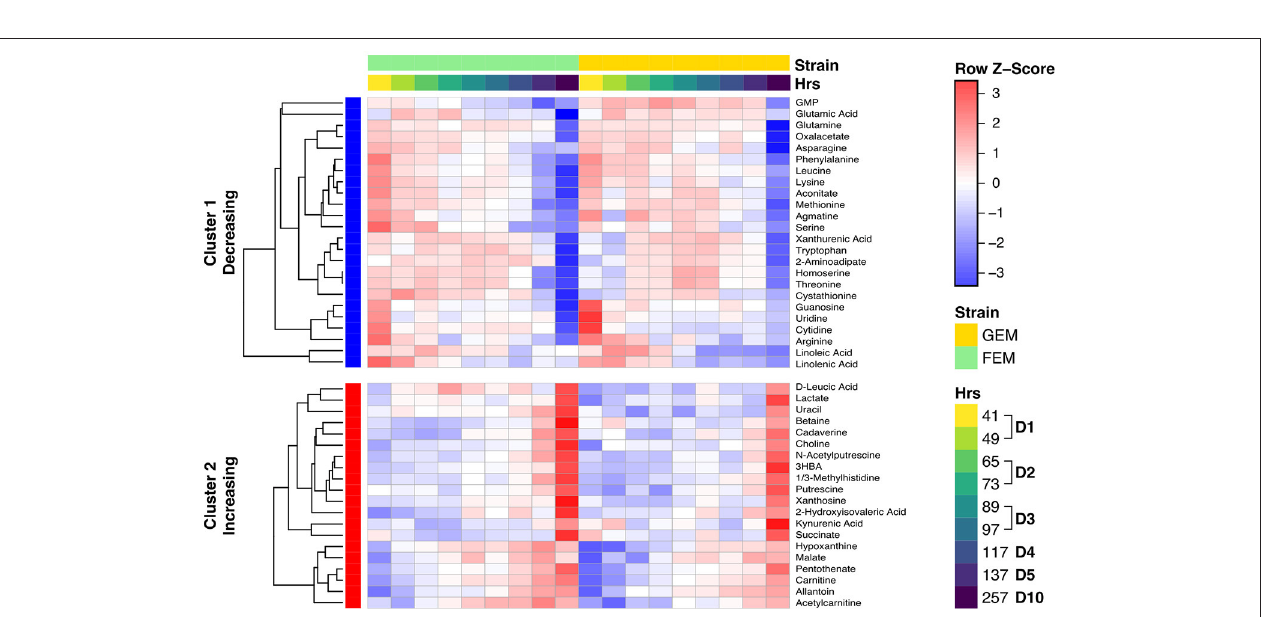
FIGURE 3 | Bubble plot of pathway enrichment for age-associated metabolites. The pathways that are most red are the ones that have the most age-associated metabolites, while the ones that are the most blue have the least. Circle radius represents the number of measured metabolites in the pathway. The x axis shows the proportion of metabolites in the pathway that are changing intensity with age in our study, and the y axis shows the proportion of metabolites in the pathway that are known to modulate longevity in the Drug Age database, illustrating that these measures are broadly correlated.